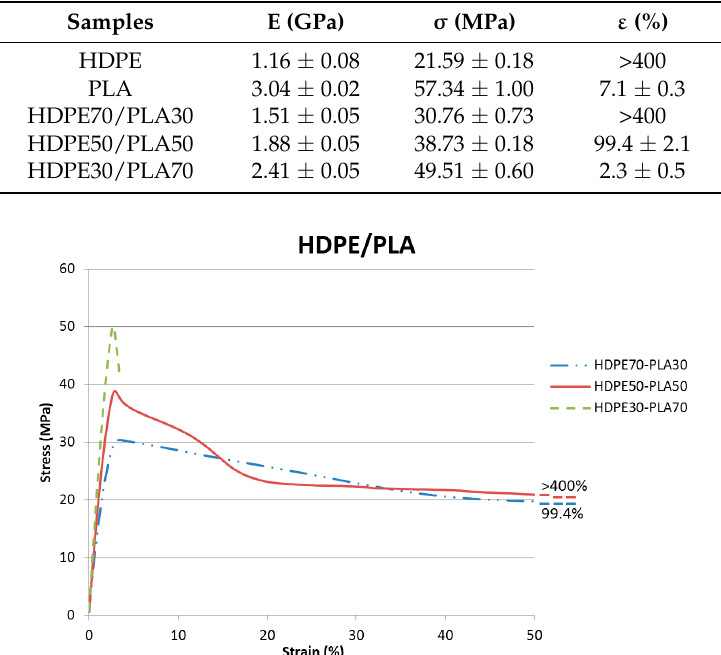
Table 2. Tensile tests results of HDPE/PLA blends without compatibilizers.